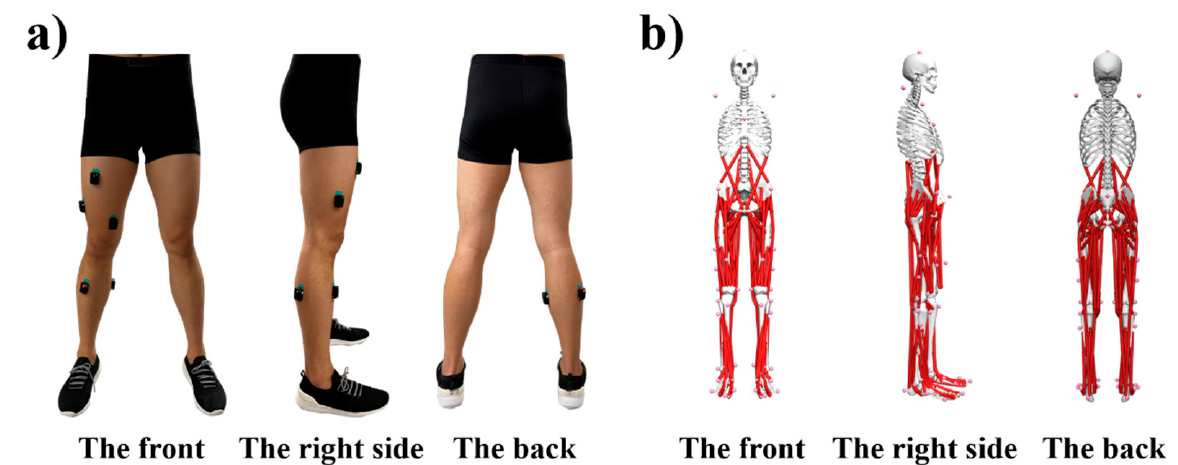
Figure 2. ( a ) Illustration of the placements of the EMG sensor on three different sides. ( b ) Illustration of the placements of the marker on three different sides.